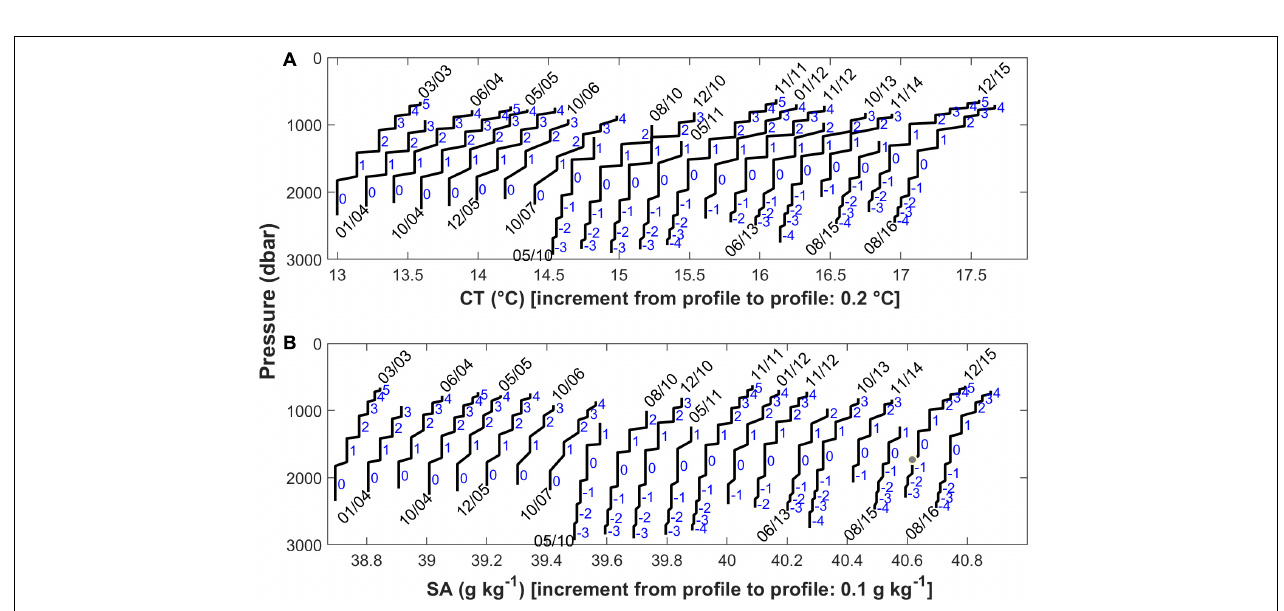
FIGURE 4 | (A) CT ( ◦ C) and (B) SA (g kg − 1 ) profiles for each cruise obtained by matching the depth level of every detected corner point with the average value of CT and SA in the layer above (for a j u corner point) or below (for a j l corner point) it. Profiles are offset by 0.2 ◦ C and 0.1 g kg − 1 from cruise to cruise for better viewing. The layers are numbered as in Figure 3